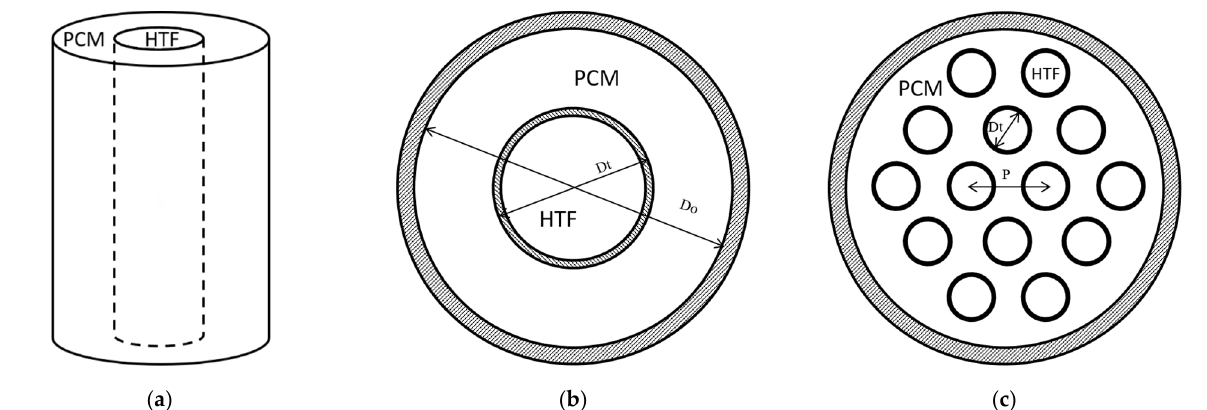
Figure 4. Physical model discussed in this study: ( a ) shell-and-tube LHTES unit in 3D view; ( b ) double pipe configuration; and ( c ) multiple pipe configuration.